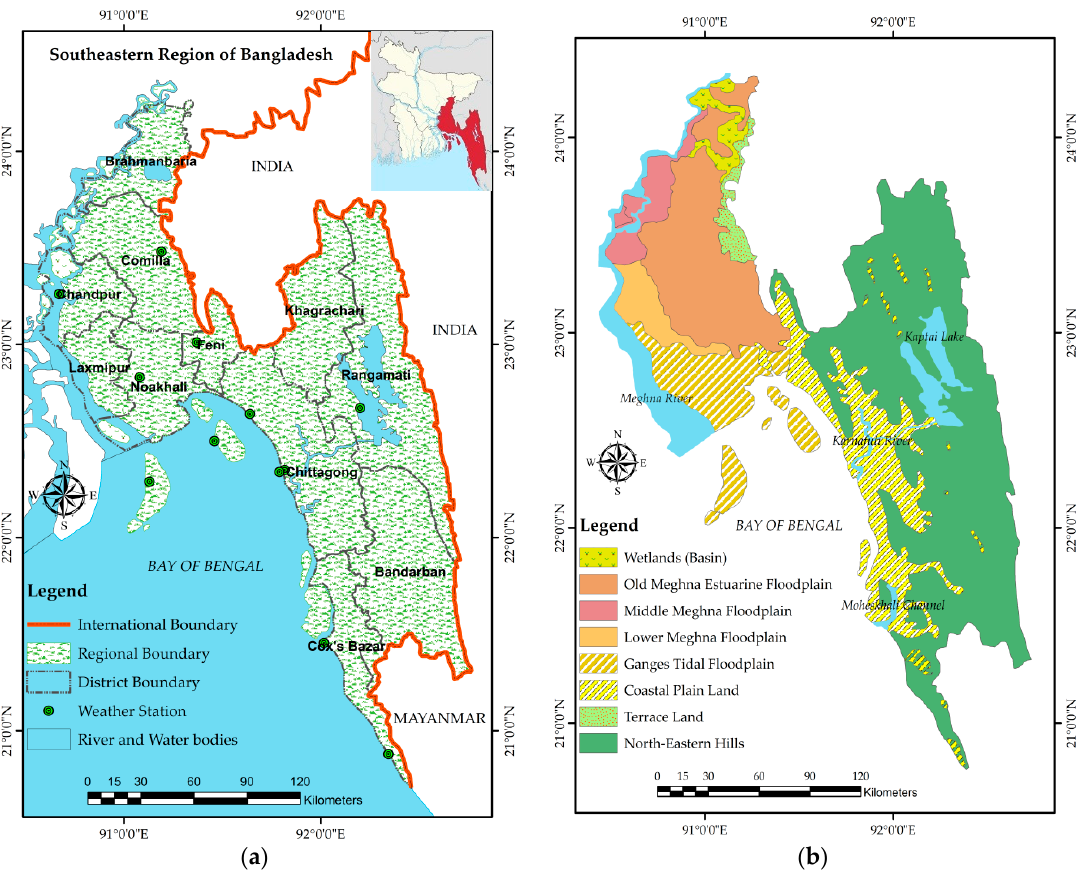
Figure 1. ( a ) Location of the study area and ( b ) physiographic character ofthe southeastern region of Bangladesh (Source: Banglapedia and BARC, 2010).